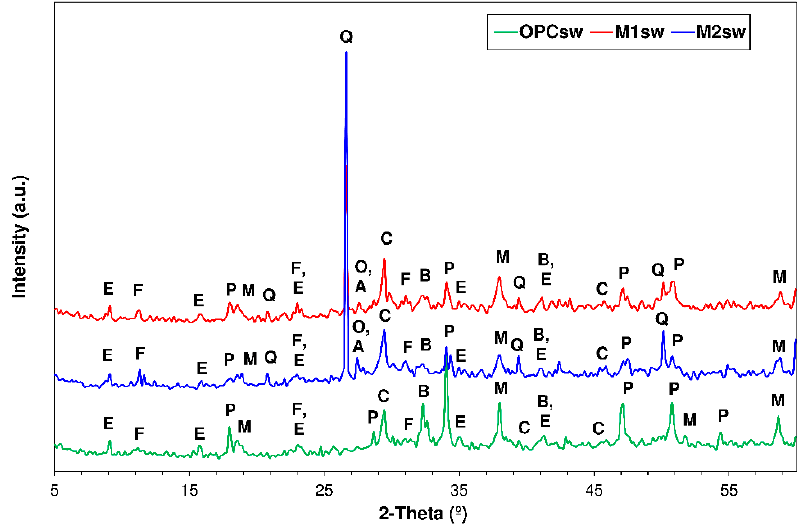
Figure 5. XRD patterns for 56 d OPC, M1 and M2 exposed to seawater (Note—E: ettringite; M: brucite; P: portlandite; Q: quartz; O: orthoclase; A: Albite; C: calcite; and B: belite).